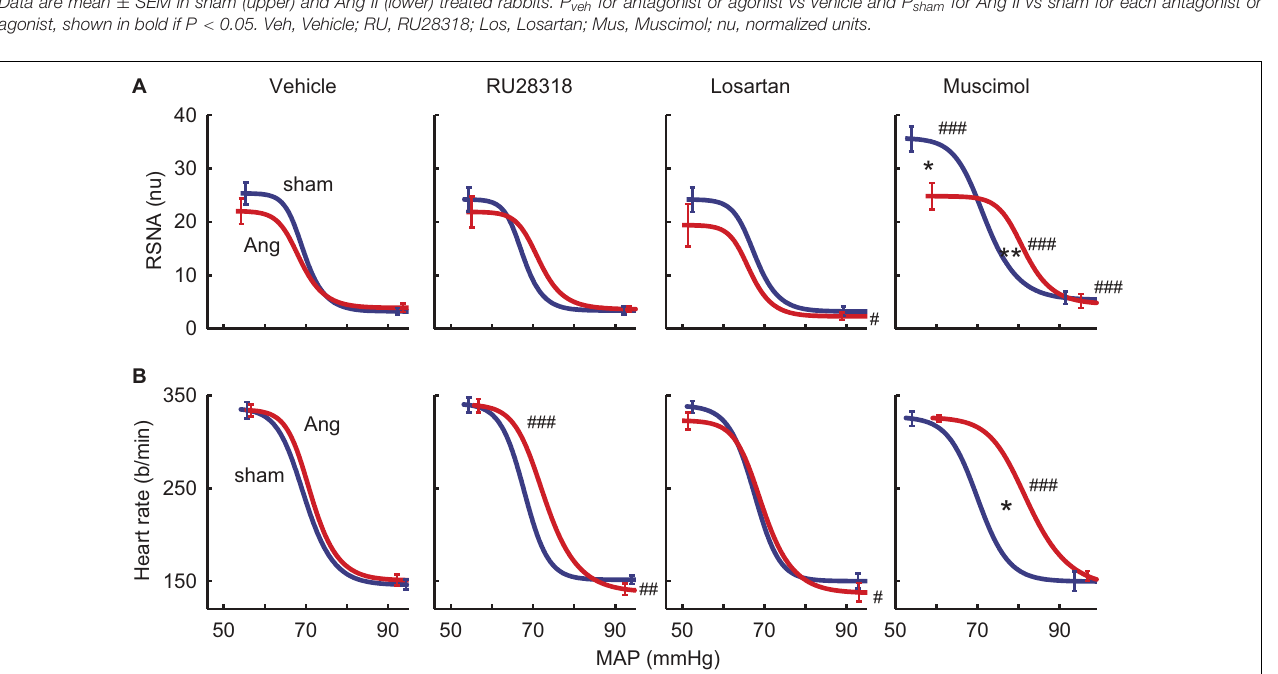
to show that an infusion of small interfering RNA against MR or AT 1 R into the SFO prevented most of the Ang II- induced hypertension and that the mechanism involving Ang II induction of reactive oxygen species in the PVN required activation of MR signaling in the SFO (Wang et al.,